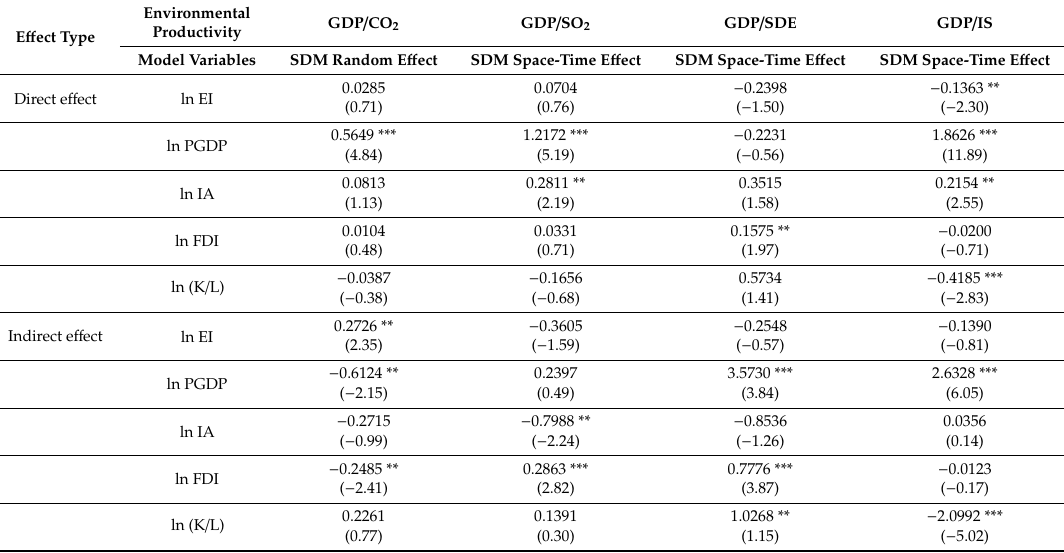
Table 10. Direct and spillover e ff ects of variables on environmental